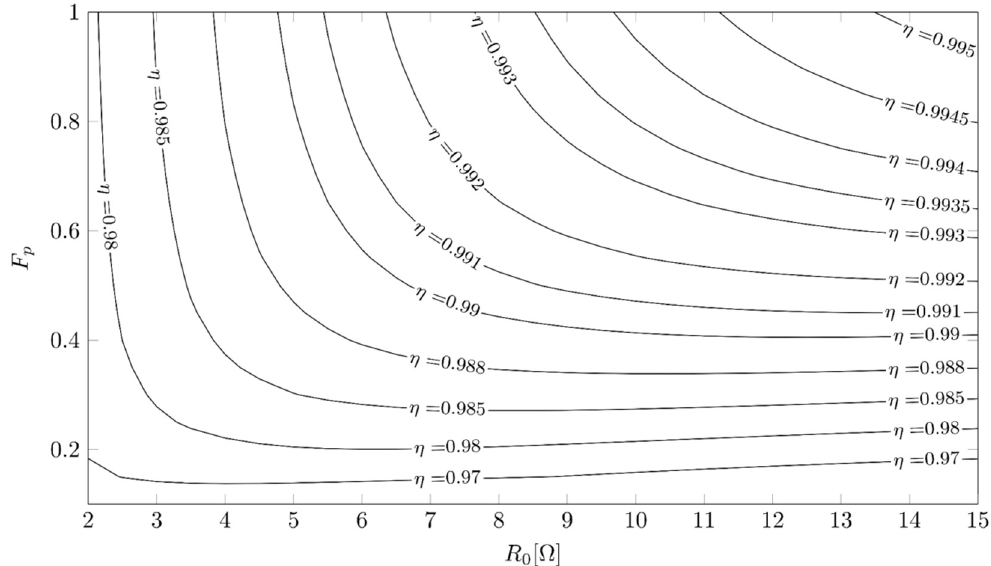
Figure 7. Analytically obtained efficiency of a 3 phase SiC MOSFET Inverter with device S4 from Table 1 as a function of the load impedance here divided in resistance and power factor.